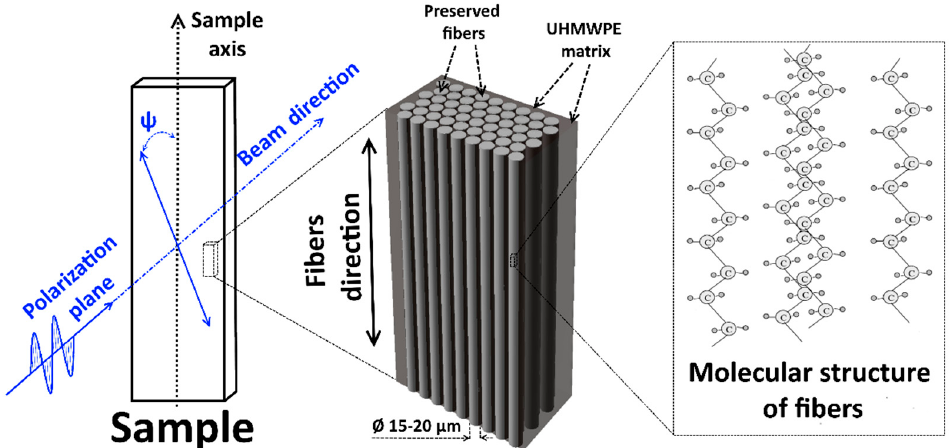
Figure 5. Position of the initial beam polarization relative to the sample, fibers and